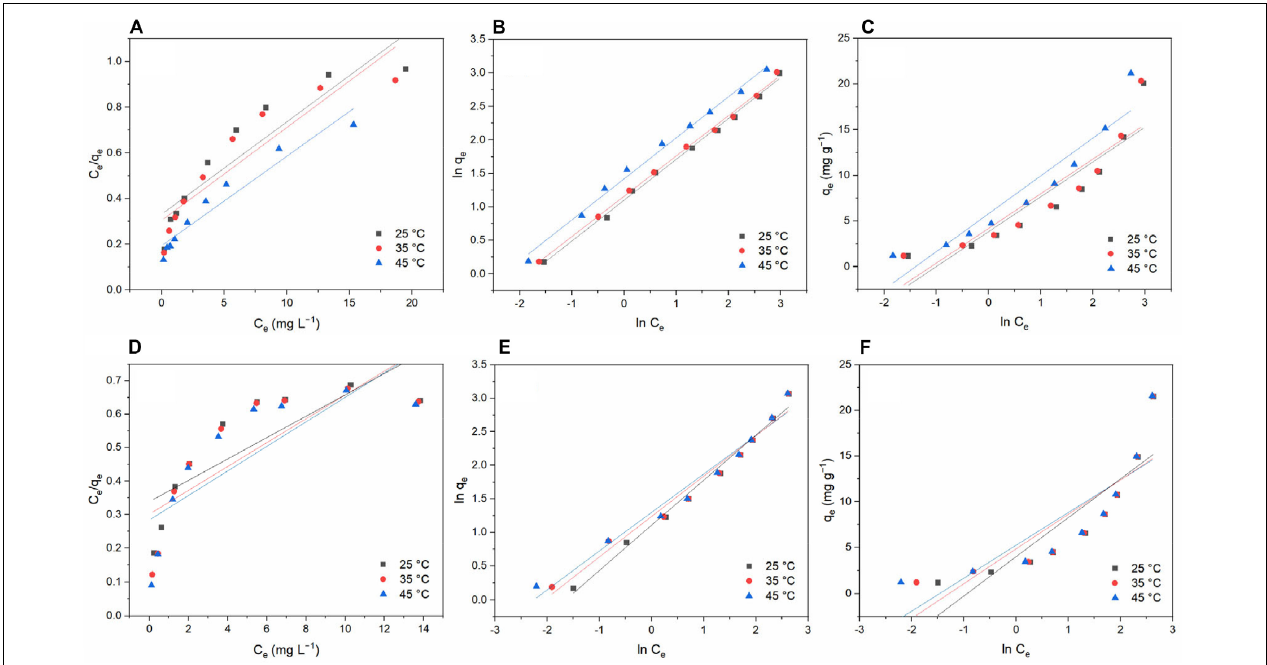
FIGURE 9 | Equilibrium isotherms for tetracycline hydrochloride and doxycycline adsorbed by BC/MnO 2 at different temperatures: (A) Langmuir model for TC; (B) Freundlich model for TC; (C) Temkin model for TC; (D) Langmuir model for DC; (E) Freundlich model for DC; and (F) Temkin model for DC.